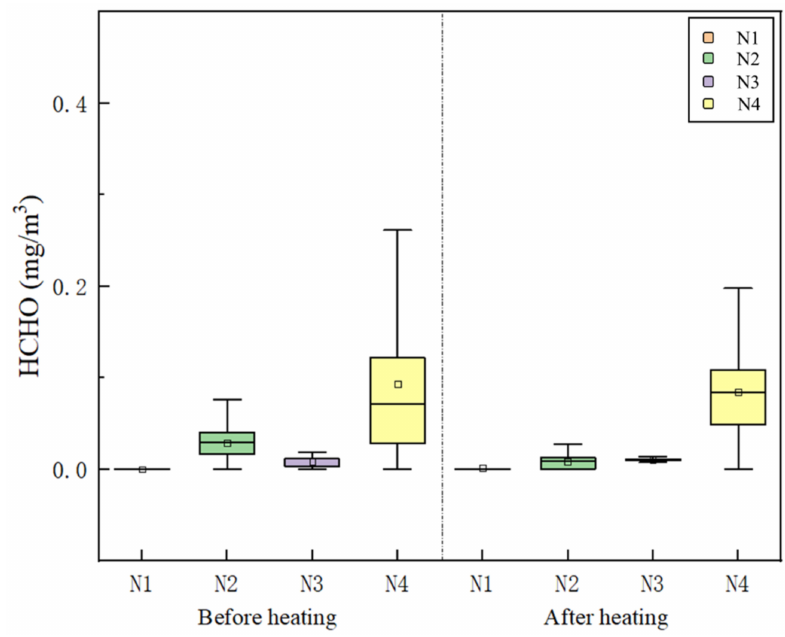
Figure 14. Box diagram of